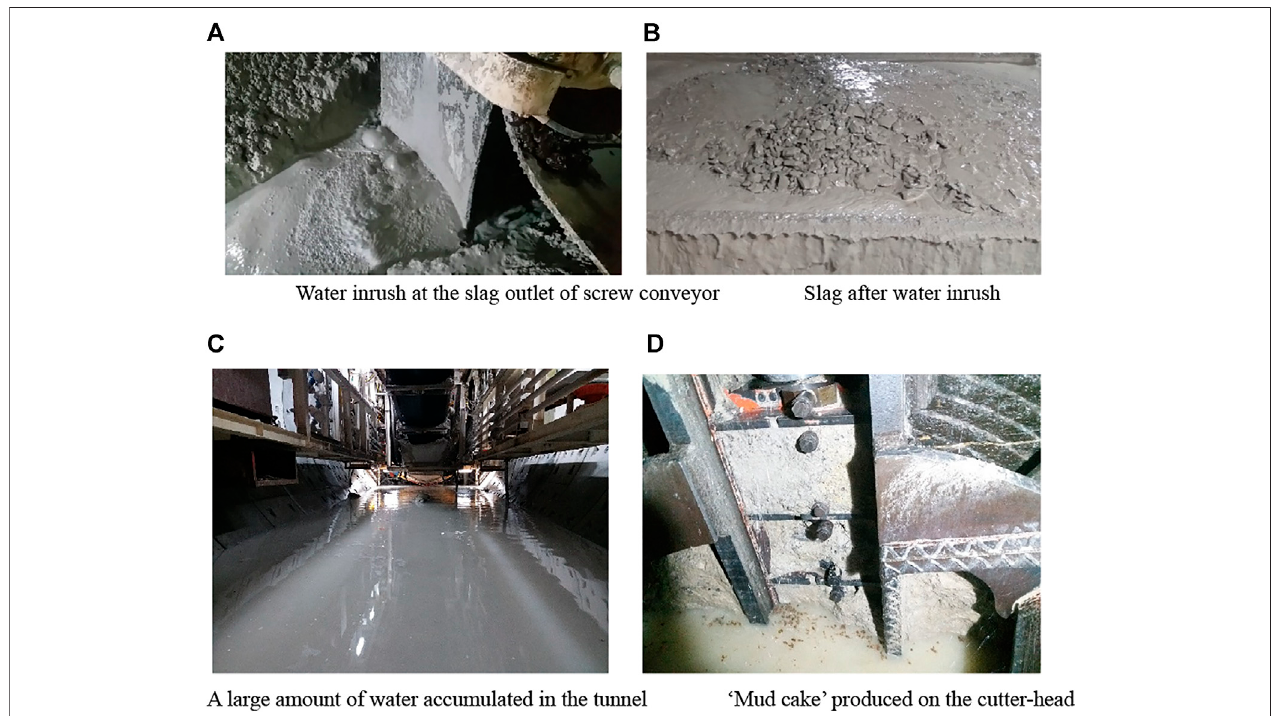
FIGURE 6 | Risks to shield tunneling caused by severe water inrush. (A) Water inrush at the slag outlet of screw conveyor. (B) Slag after water inrush. (C) A large amount of water accumulated in the tunnel. (D) “ Mud cake ” produced on the cutterhead.